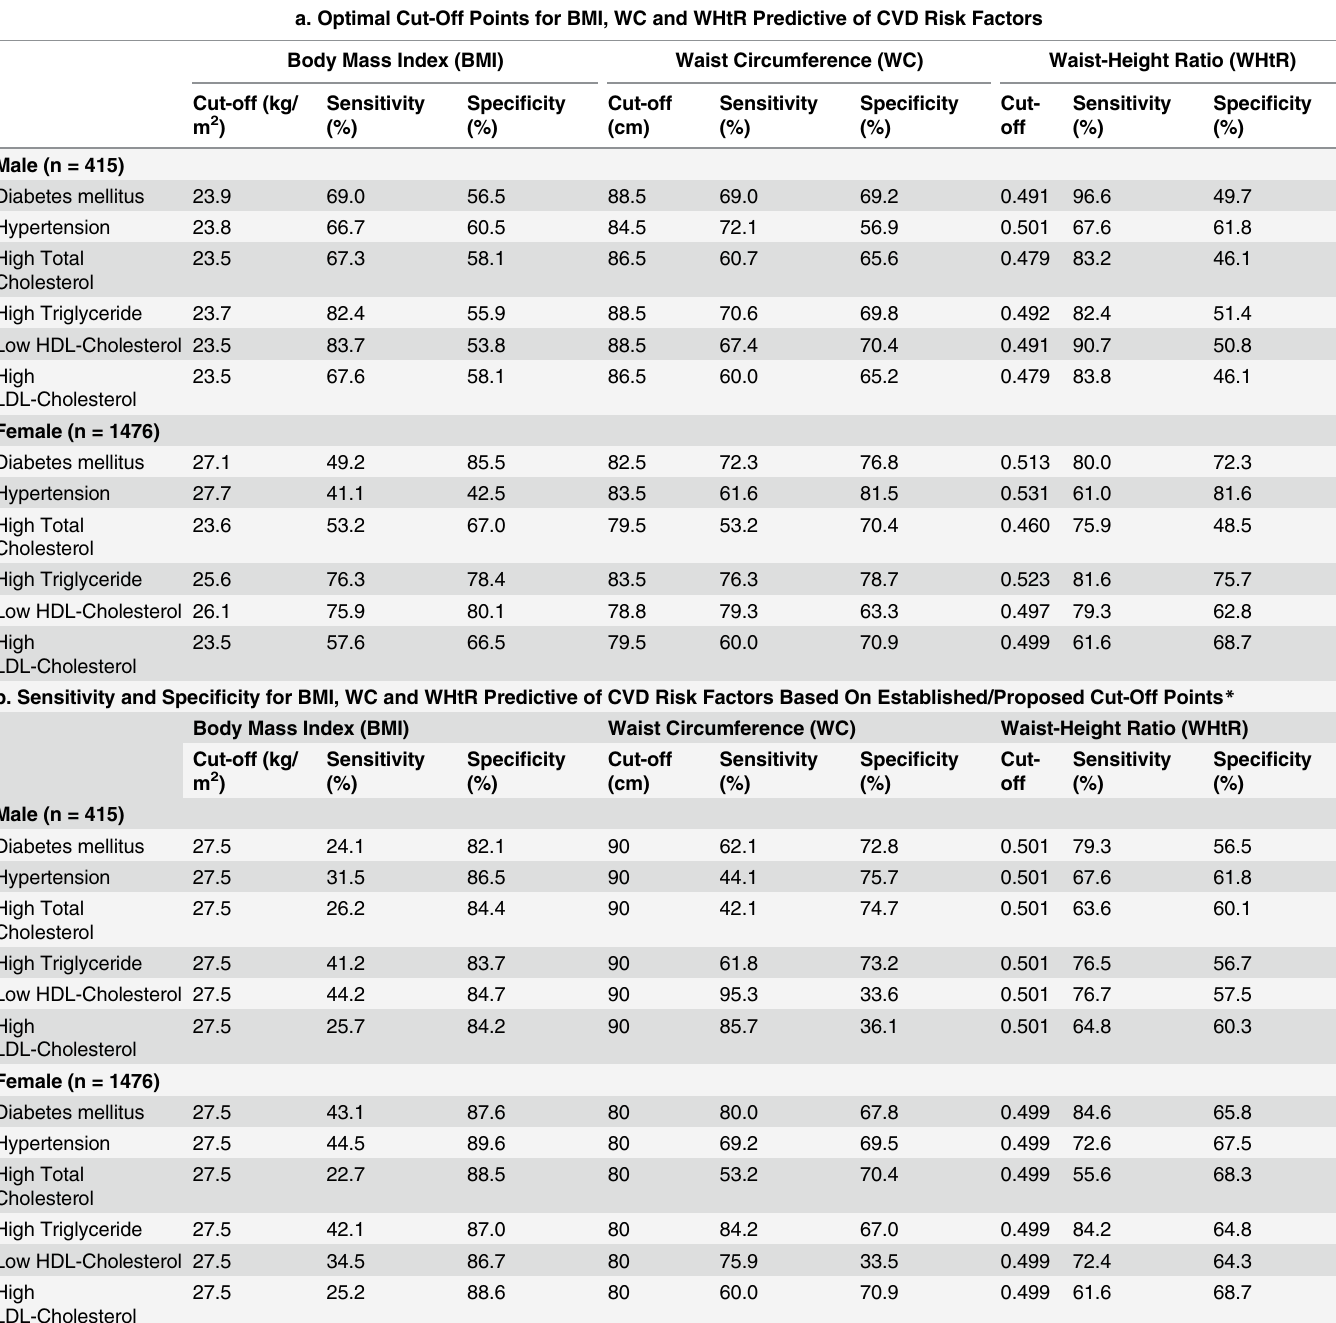
Table 4. Cut-Off Points, Sensitivity and Specificity for BMI, WC and WHtR Predictive of Cardiovascular Disease Risk Factors. a. Optimal Cut-Off Points for BMI, WC and WHtR Predictive of CVD Risk Factors